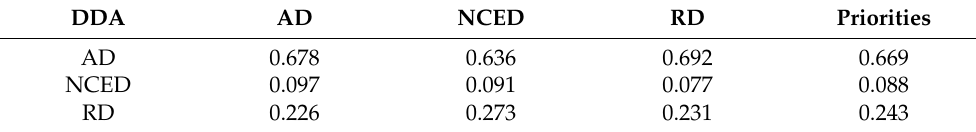
Table 6. Subscales’ priorities.